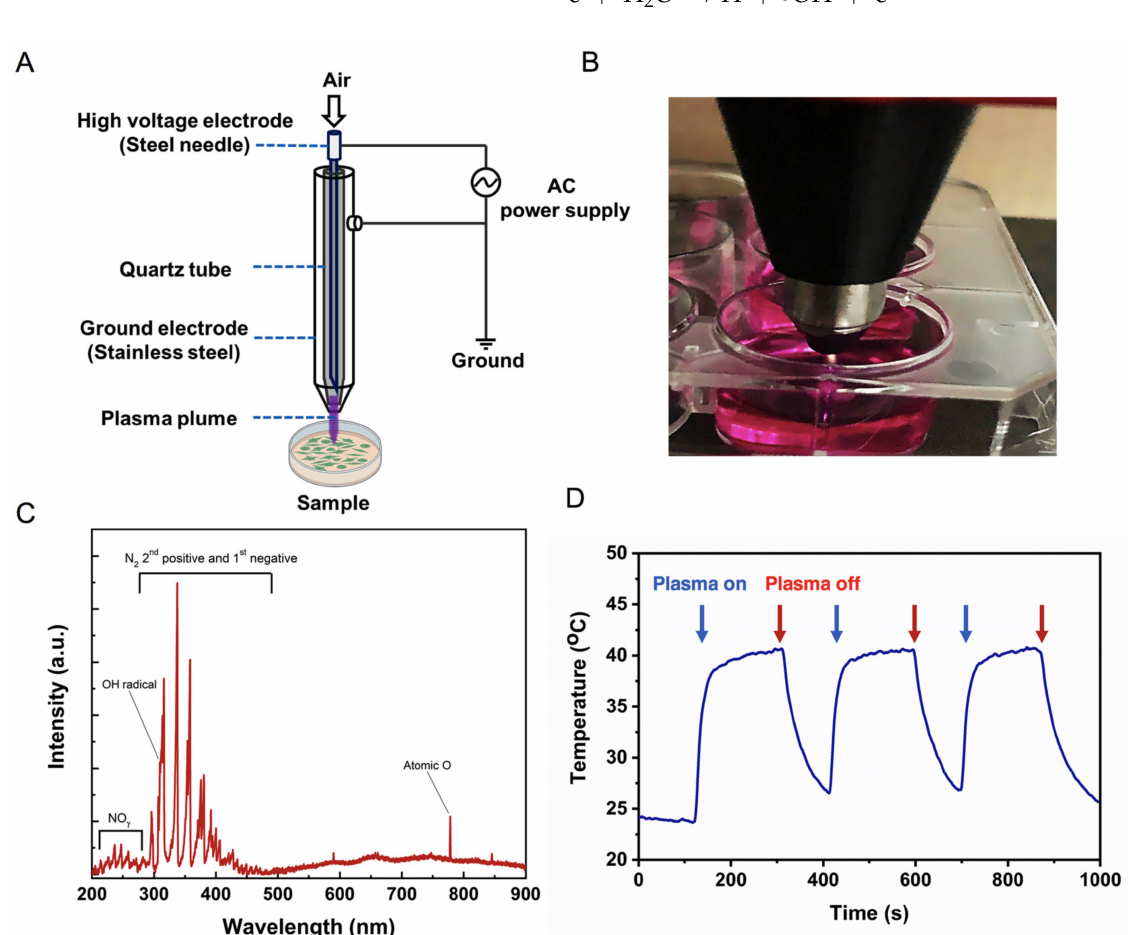
Figure 1. Physical characteristics of the soft jet plasma device. ( A ) Schematic representation of soft jet plasma device used in this study. ( B ) Photograph of the performing soft jet plasma. ( C ) Optical emission spectrum of the plasma jet, showing emissions of NO, the N 2 second positive system (N 2 SPS) and the N 2 first negative system (N 2 FNS), OH radical, and atomic O. ( D ) Temperature profile of the plasma jet plume during